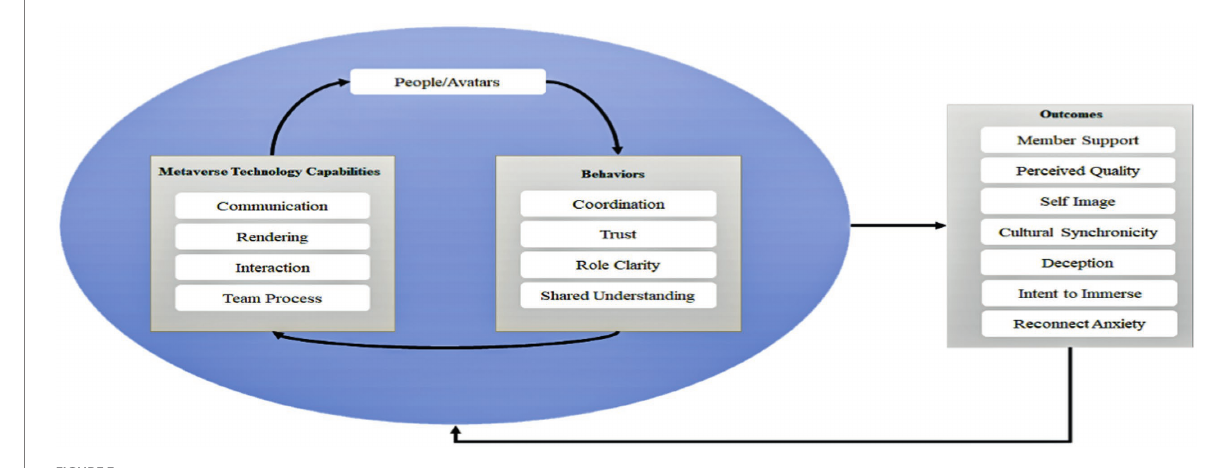
FIGURE 3 A diagram for the Davis et al. (2009) framework for the study of the metaverse.